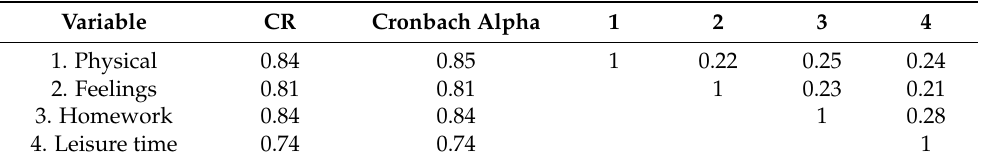
Table 3. Composite reliability (CR), Cronbach’s alpha (CA) and the factor correlation of the final model for the